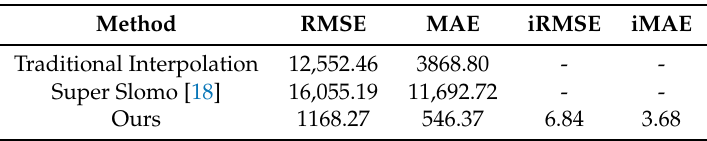
Table 2. Quantative evaluation results of the traditional interpolation method, Super Slomo [18], and our method.